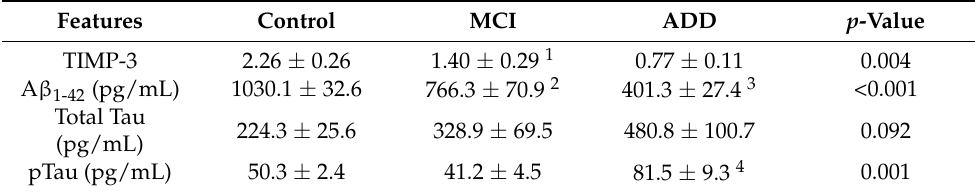
Table 3. CSF levels of Control Subjects, MCI and ADD patients.